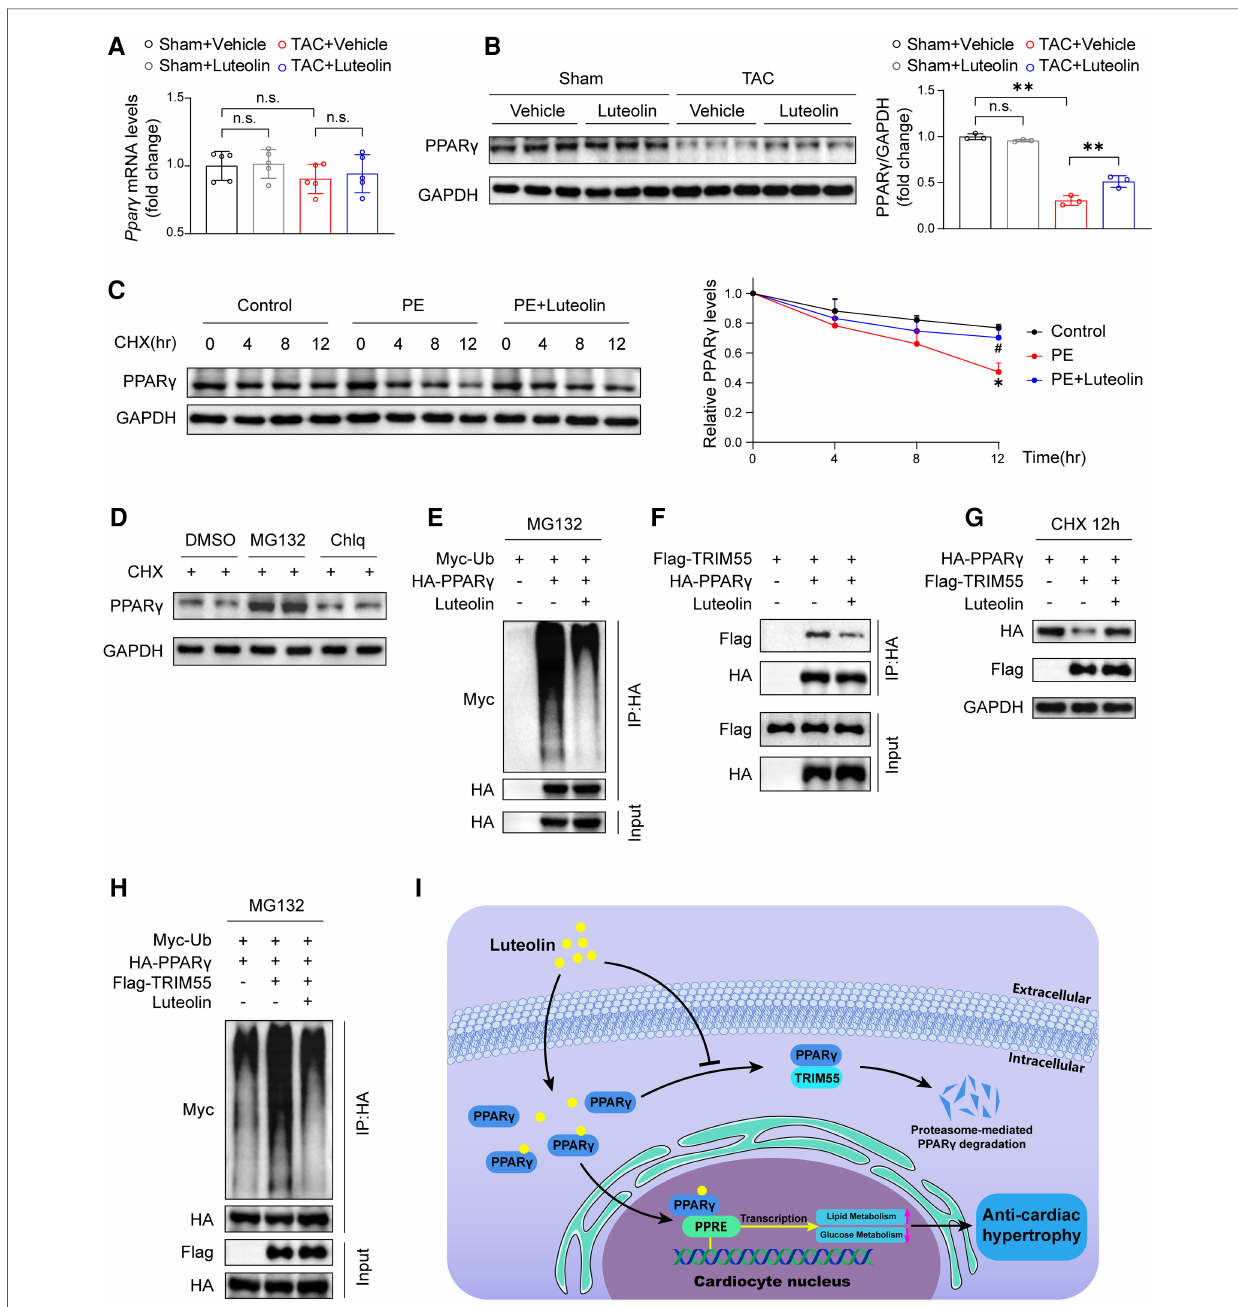
FIGURE 8 Luteolin elevates the stability of PPAR γ via inhibiting PPAR γ ubiquitination. ( A ) Relative mRNA levels of PPAR γ in the mice hearts at 12 weeks after sham or TAC surgery ( n =5). Values are presented as mean±SD. n.s., no signi fi cant difference. ( B ) Immunoblotting analysis (left) and quantitative results (right) of PPAR γ in the mice hearts at 12 weeks after sham or TAC surgery ( n =5). Values are presented as mean±SD. ** P <0.01, n.s., no signi fi cant difference. ( C ) Immunoblotting analysis (left) and quantitative results (right) of PPAR γ protein in NRCMs exposed to CHX (100 μ M) for the indicated time with or without the luteolin treatment. The data shown are representative of three independent experiments. Values are presented as mean±SD. * P <0.05 compared to the control group. # P <0.05 compared to the PE group. ( D ) PPAR γ protein levels in NRCMs exposed to MG132 (10 μ M) or Chlq (25 μ M) in the presence of CHX (100 μ M) for 4 h. The data shown are representative of three independent experiments. ( E ) The ubiquitination levels of PPAR γ in HEK 293 T cells transfected with HA-tagged PPAR γ and Myc-tagged Ub exposed to DMSO or luteolin (10 μ M) in the presence of MG132 (10 μ M). The data shown are representative of three independent experiments. ( F ) IP analyses of the interaction between TRIM55 and PPAR γ in HEK 293 T cells transfected indicated plasmids exposed to DMSO or luteolin (10 μ M). The data shown are representative of three independent experiments. ( G ) PPAR γ protein levels in HEK 293 T cells transfected with HA-tagged PPAR γ and Flag-tagged TRIM55 exposed to DMSO or luteolin (10 μ M) in the presence of CHX (100 μ M) for 12 h. The data shown are representative of three independent experiments. ( H ) The ubiquitination levels of PPAR γ in HEK 293 T cells transfected with HA-tagged PPAR γ , Flag-tagged TRIM55, and Myc-tagged Ub exposed to DMSO or luteolin (10 μ M) in the presence of MG132 (10 μ M). The data shown are representative of three independent experiments. ( I ) Schematic illustrating the model that luteolin is a promising therapeutic compound for pathological cardiac hypertrophy and heart failure by directly targeting PPAR γ ubiquitin-proteasomal degradation and metabolic homeostasis. PPAR γ , peroxisome proliferator activated receptor γ ; DMSO, dimethyl sulfoxide; CHX, cycloheximide; Ub, ubiquitin; PE, phenylephrine; TRIM55, tripartite motif containing 55; NRCM, primary neonatal rat cardiomyocyte; PPRE, PPAR response